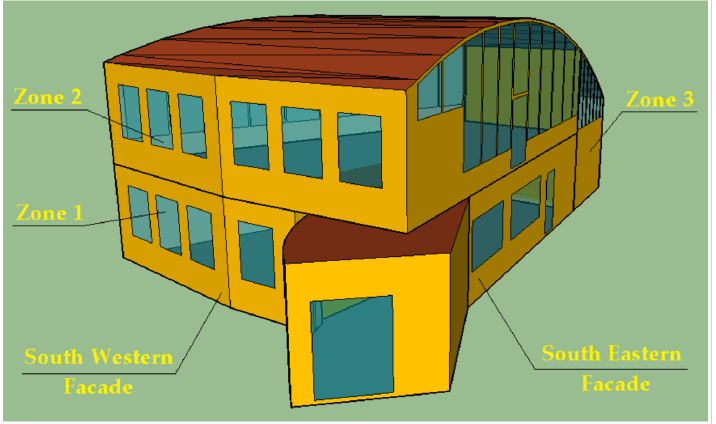
Figure 5. The 3D model of the Solar Hours created in Google